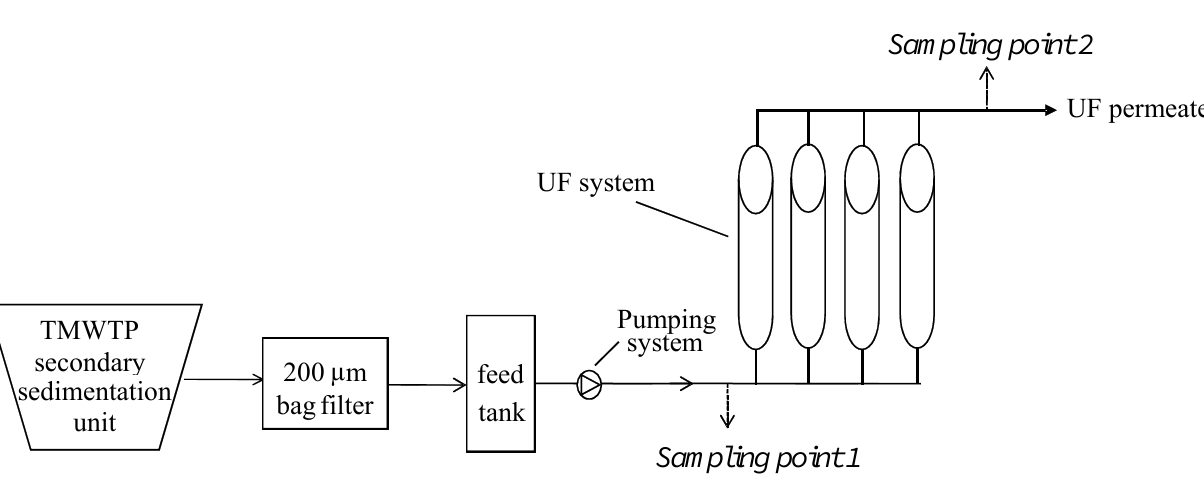
Figure 1. Flow diagram for the ultrafiltration (UF) treatment